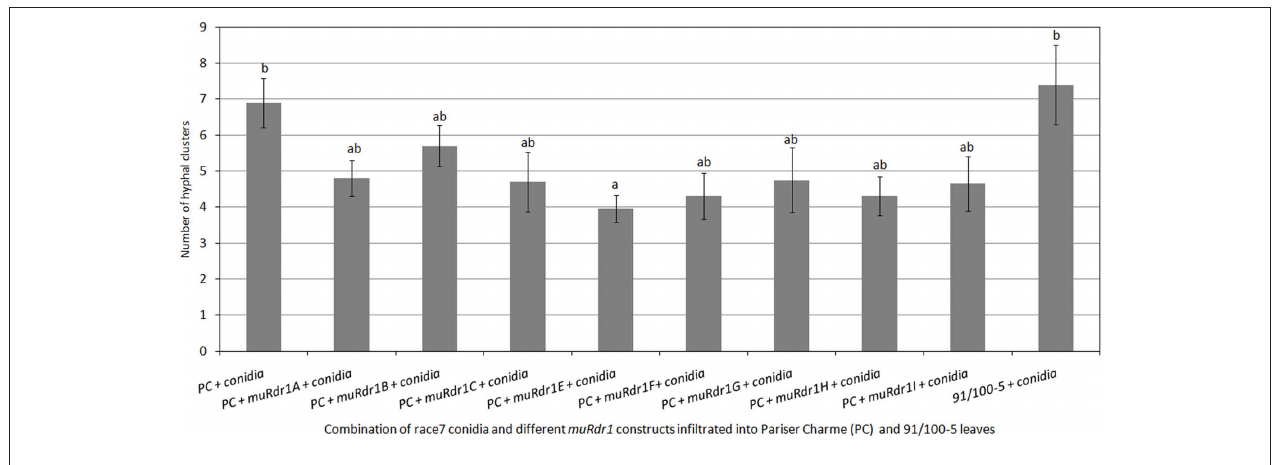
Figure 7 | Transient complementation disease assay with individual muRdr1 TNLs and race7. This graph represents average data of three independent experiments ± SEM. No significant difference in the number of